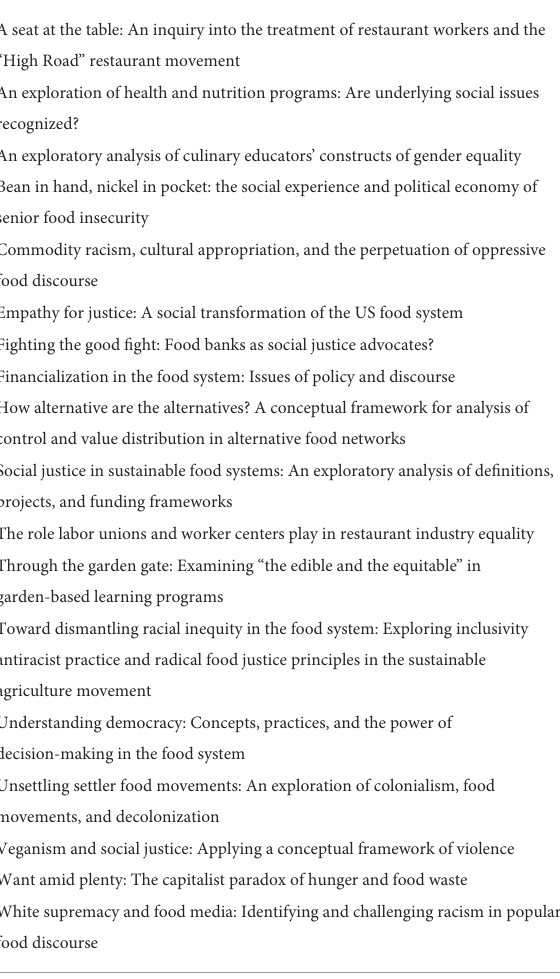
A seat at the table: An inquiry into the treatment of restaurant workers and the “High Road” restaurant